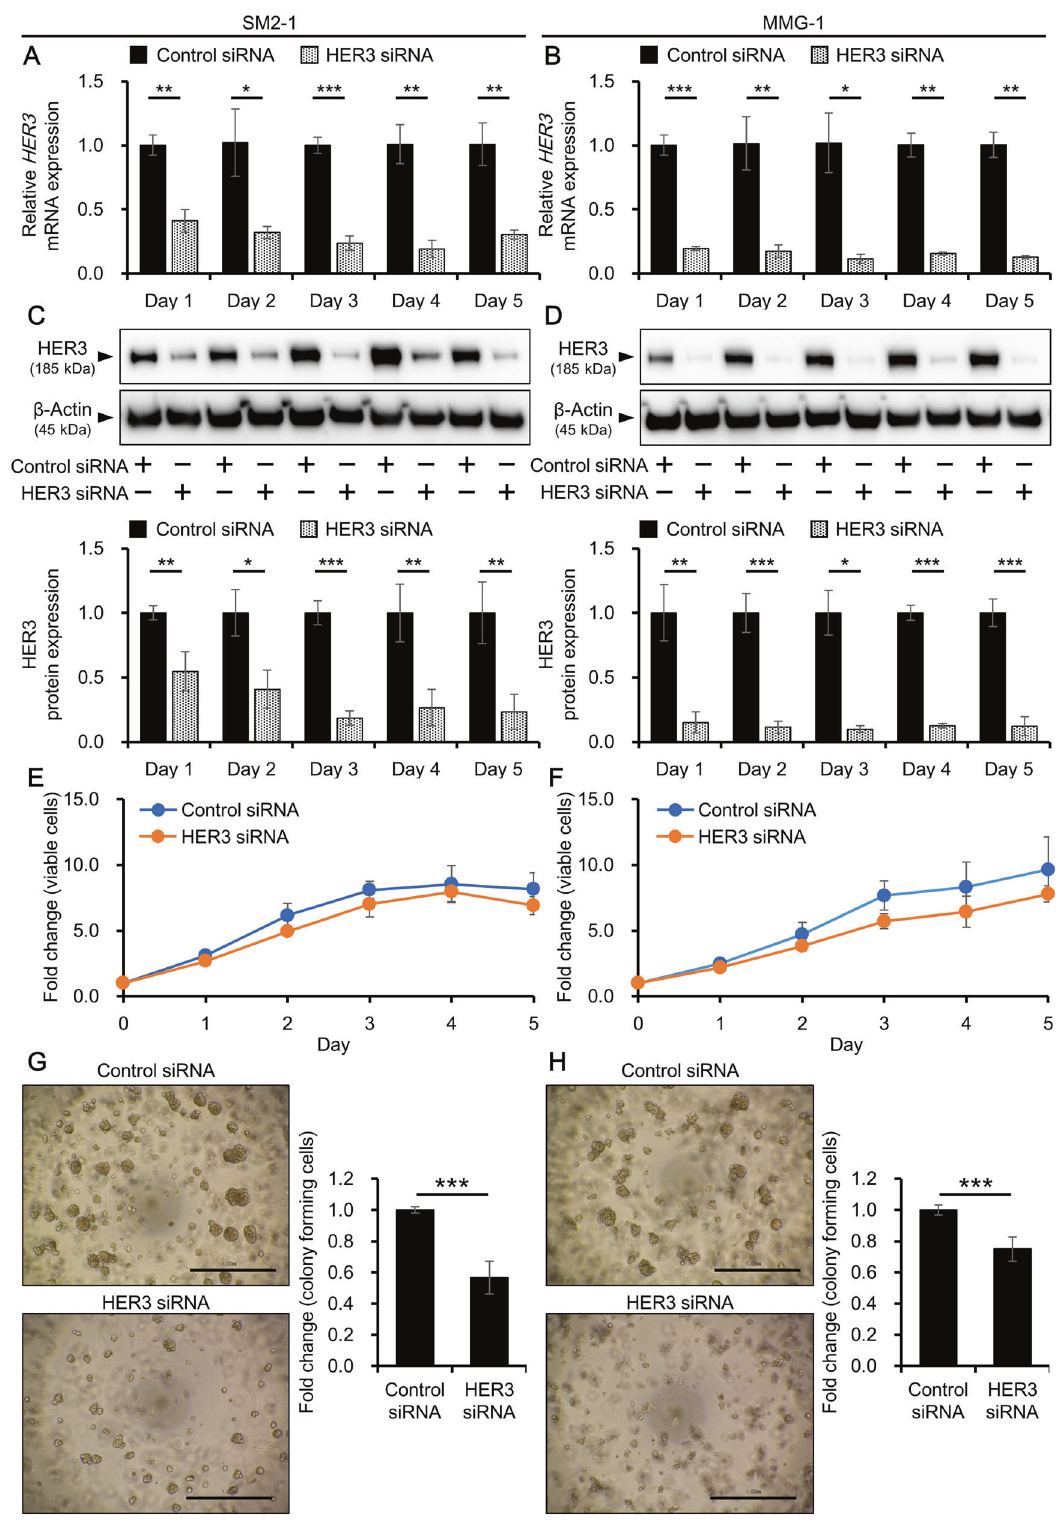
HER3 slightly decreased the proliferation of AM cells, but the difference was not statistically signi fi cant (Fig. 3E, F). In accordance with this, the cell proliferation-related genes CCND1 and C-MYC did not show distinct differences in expression between control siRNA-transfected cells and HER3 siRNA-transfected cells Cell Death Discovery (2023)